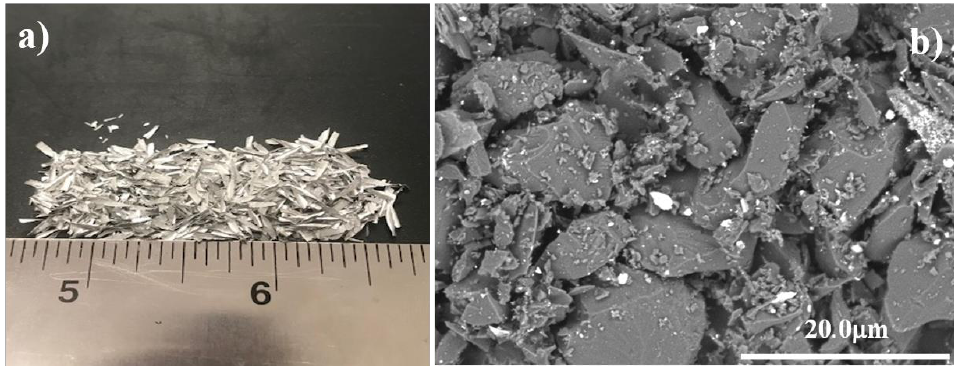
Figure 1. ( a ) Photography of the Al2024 alloy swarf and ( b ) Backscattered electron-scanning electron microscope (BE-SEM) image of the B 4 C powder.